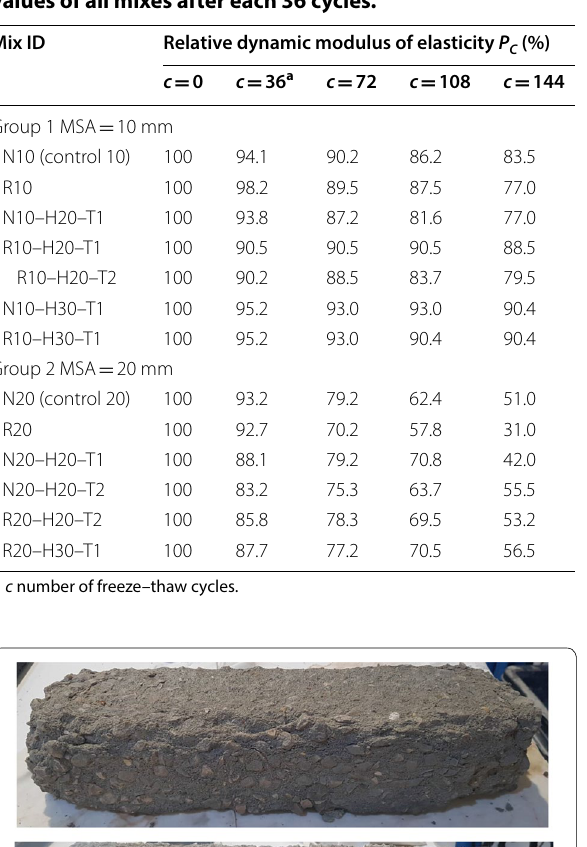
Table 10 Relative dynamic modulus of elasticity (RDME) values of all mixes after each 36 cycles.